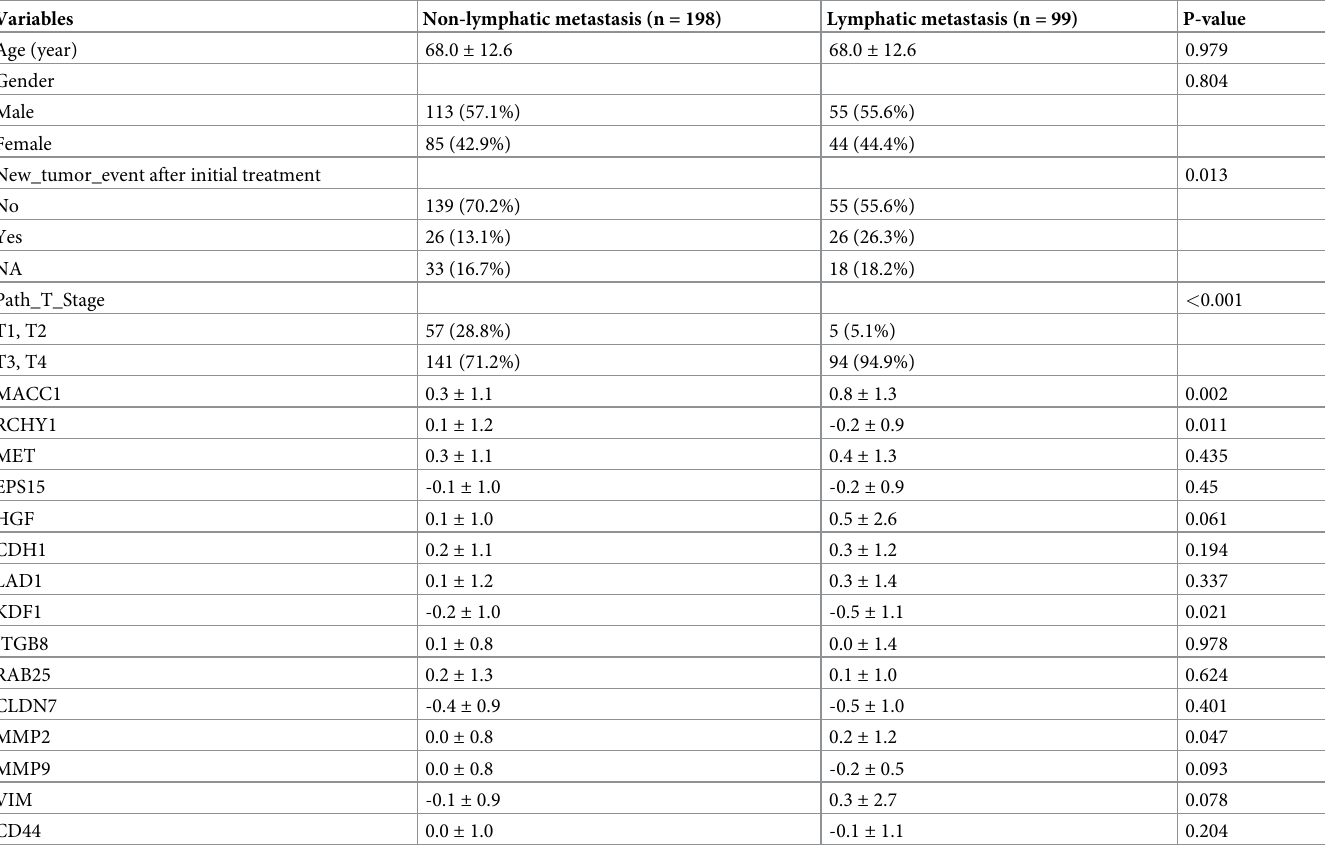
Table 1. Demographic and clinical characteristics of the cases included in the study (N =